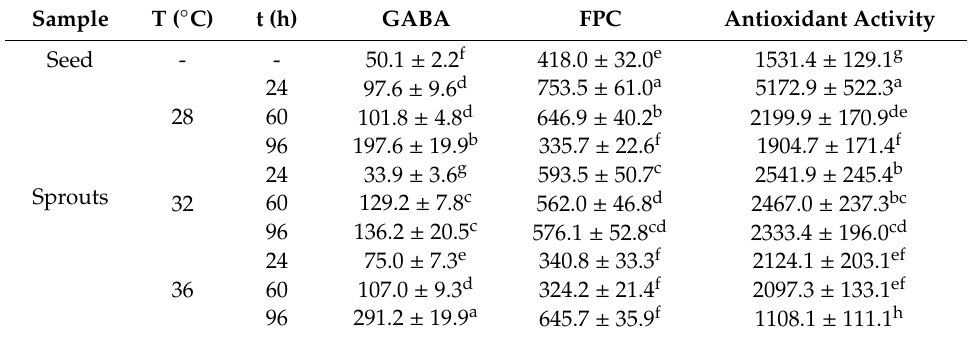
Table 4. Content of GABA (mg / 100 g d.m.), FPC (mg GAE / 100 g d.m) and antioxidant